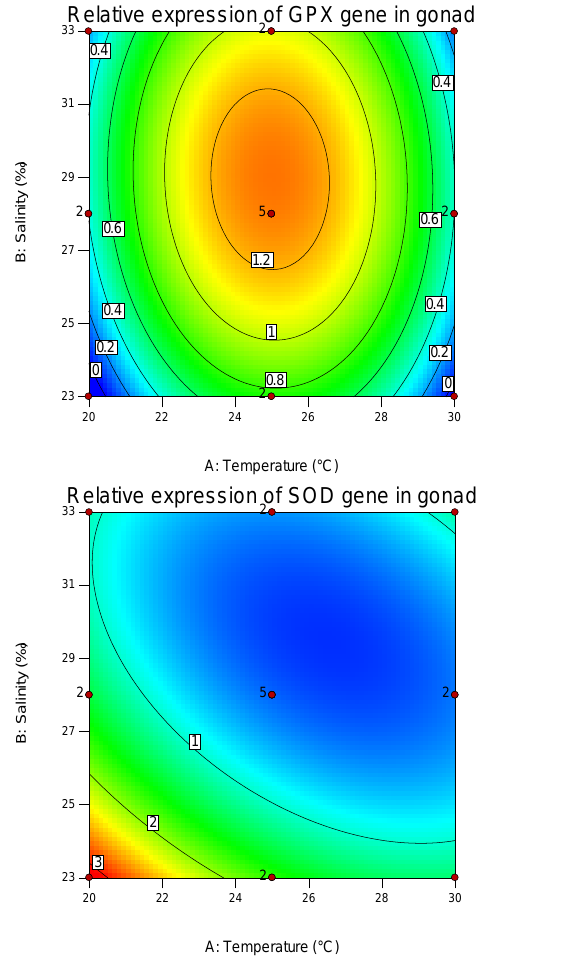
Figure 2. Response surface (right) and contour map (left) of salinity and temperature to each tissue antioxidant gene relative expression of the pearl oyster. The relative expression levels of GPX and SOD genes in the mantle, adductor muscle, foot, and gonad are shown from top to bottom.